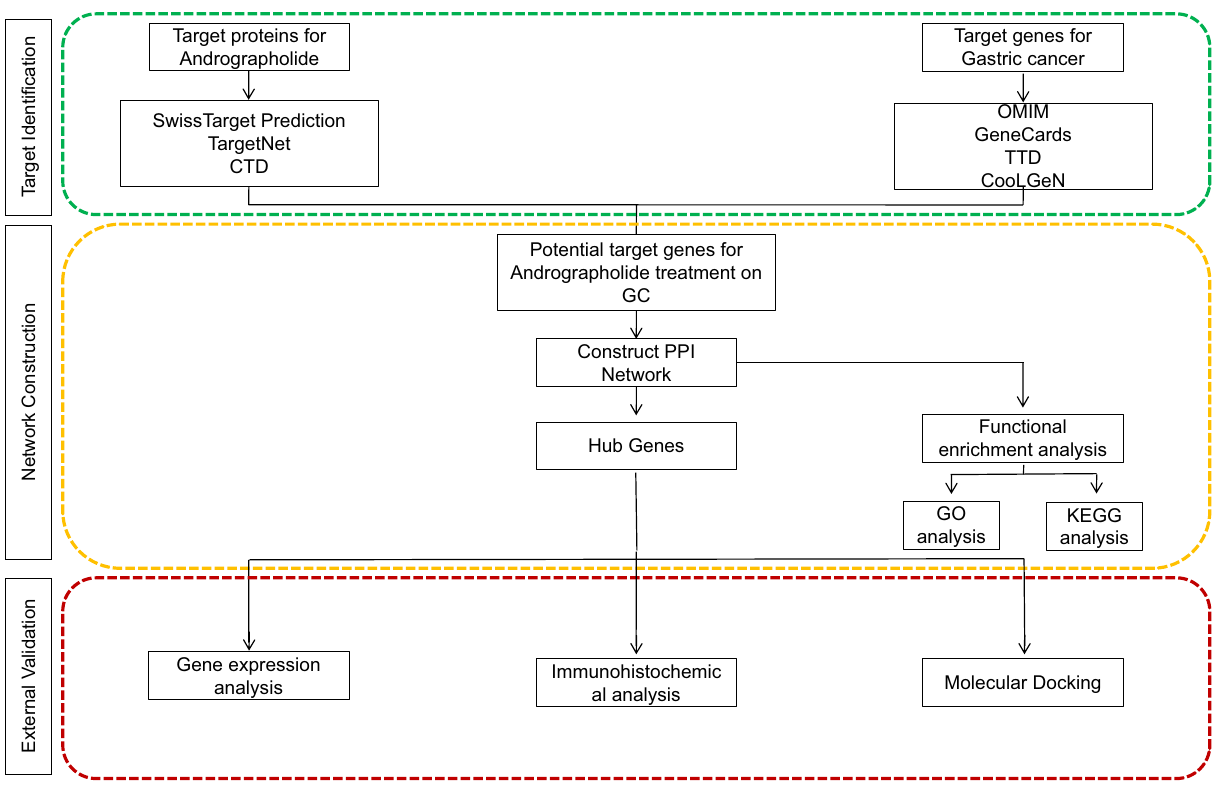
Figure 1. General workflow of network pharmacology and molecular docking in the present